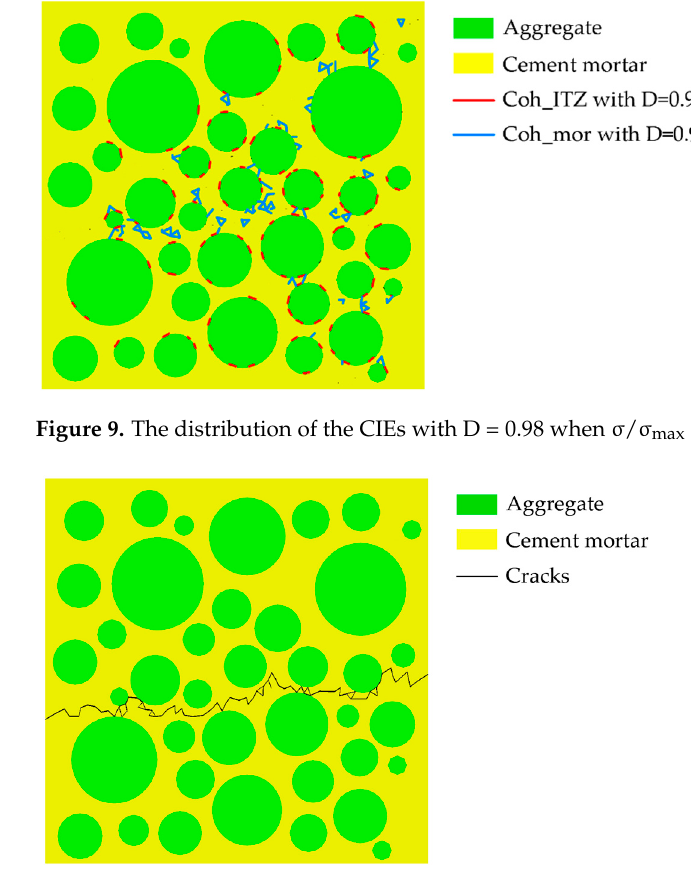
Figure 10. The macroscopic penetrating crack.